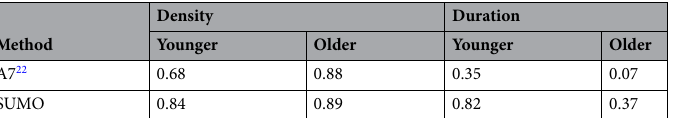
2 Table 3. Correlation coefficient r between spindle properties derived by automatic methods (A7 or SUMO) and the consensus of the expert group. Spindle density (spindles per minute) and average spindle duration were determined for each subject of the test set based on spindles identified by A7, SUMO, and the expert consensus. For each age cohort (younger, older), correlation coefficients between spindle properties based on the expert consensus and the automatic methods were